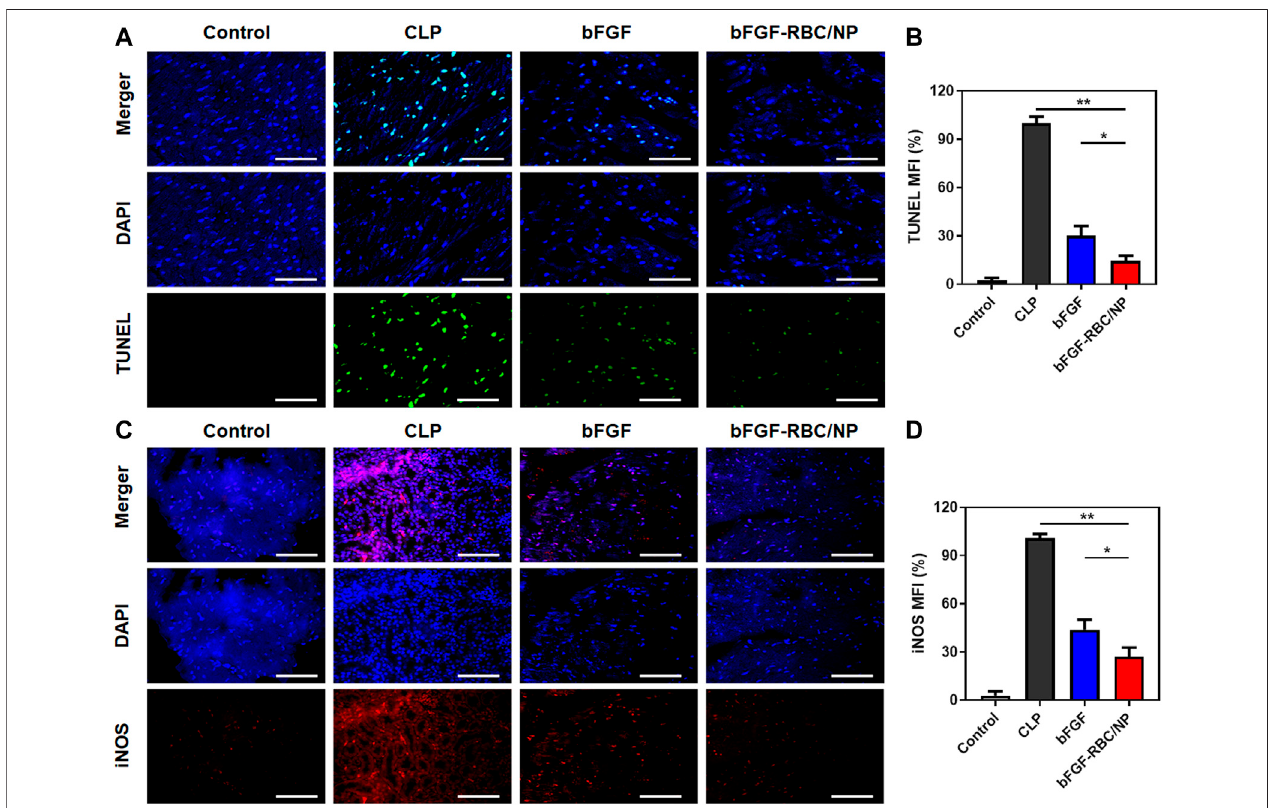
FIGURE6| FluorescentstaininganalysisofbFGF-RBC/NP. (A) TUNELand (C) immuno fl uorescentstainingofiNOSinhearttissues.Thesemi-quantitativeanalysis of the mean fl uorescent intensity of (B) TUNEL and (D) iNOS of each group. Data are expressed as the mean ± SD ( n = 3). Scale bar = 50 um. * p < 0.05 and ** p < 0.01.